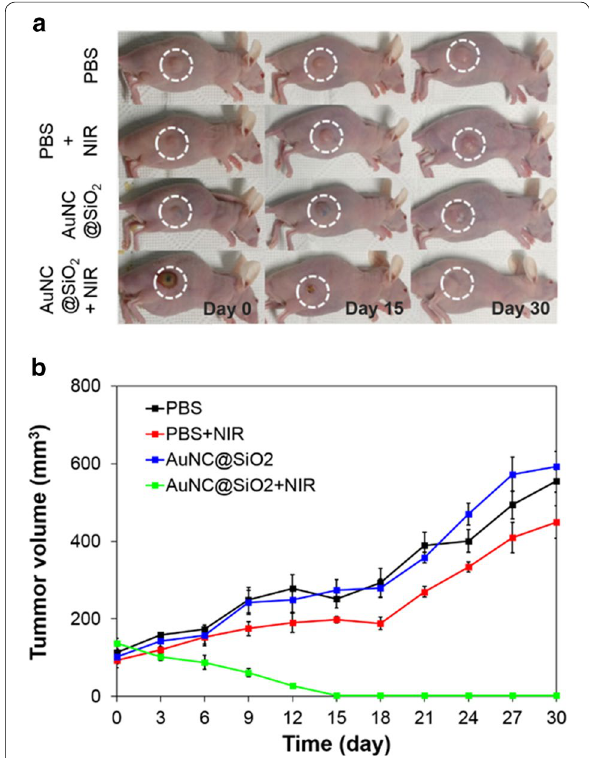
Fig. 5 Images of the treated mice depended on time and trend of tumor growth. a Tumor size of AuNC@SiO 2 PTT treated PC‑3 tumor‑implanted mice over time. Here, it is noted that the white dashed circle represents the tumor site. b Plot indicating the tumor size of AuNC@SiO 2 PTT treated mice over time. All experimental measurements were made in